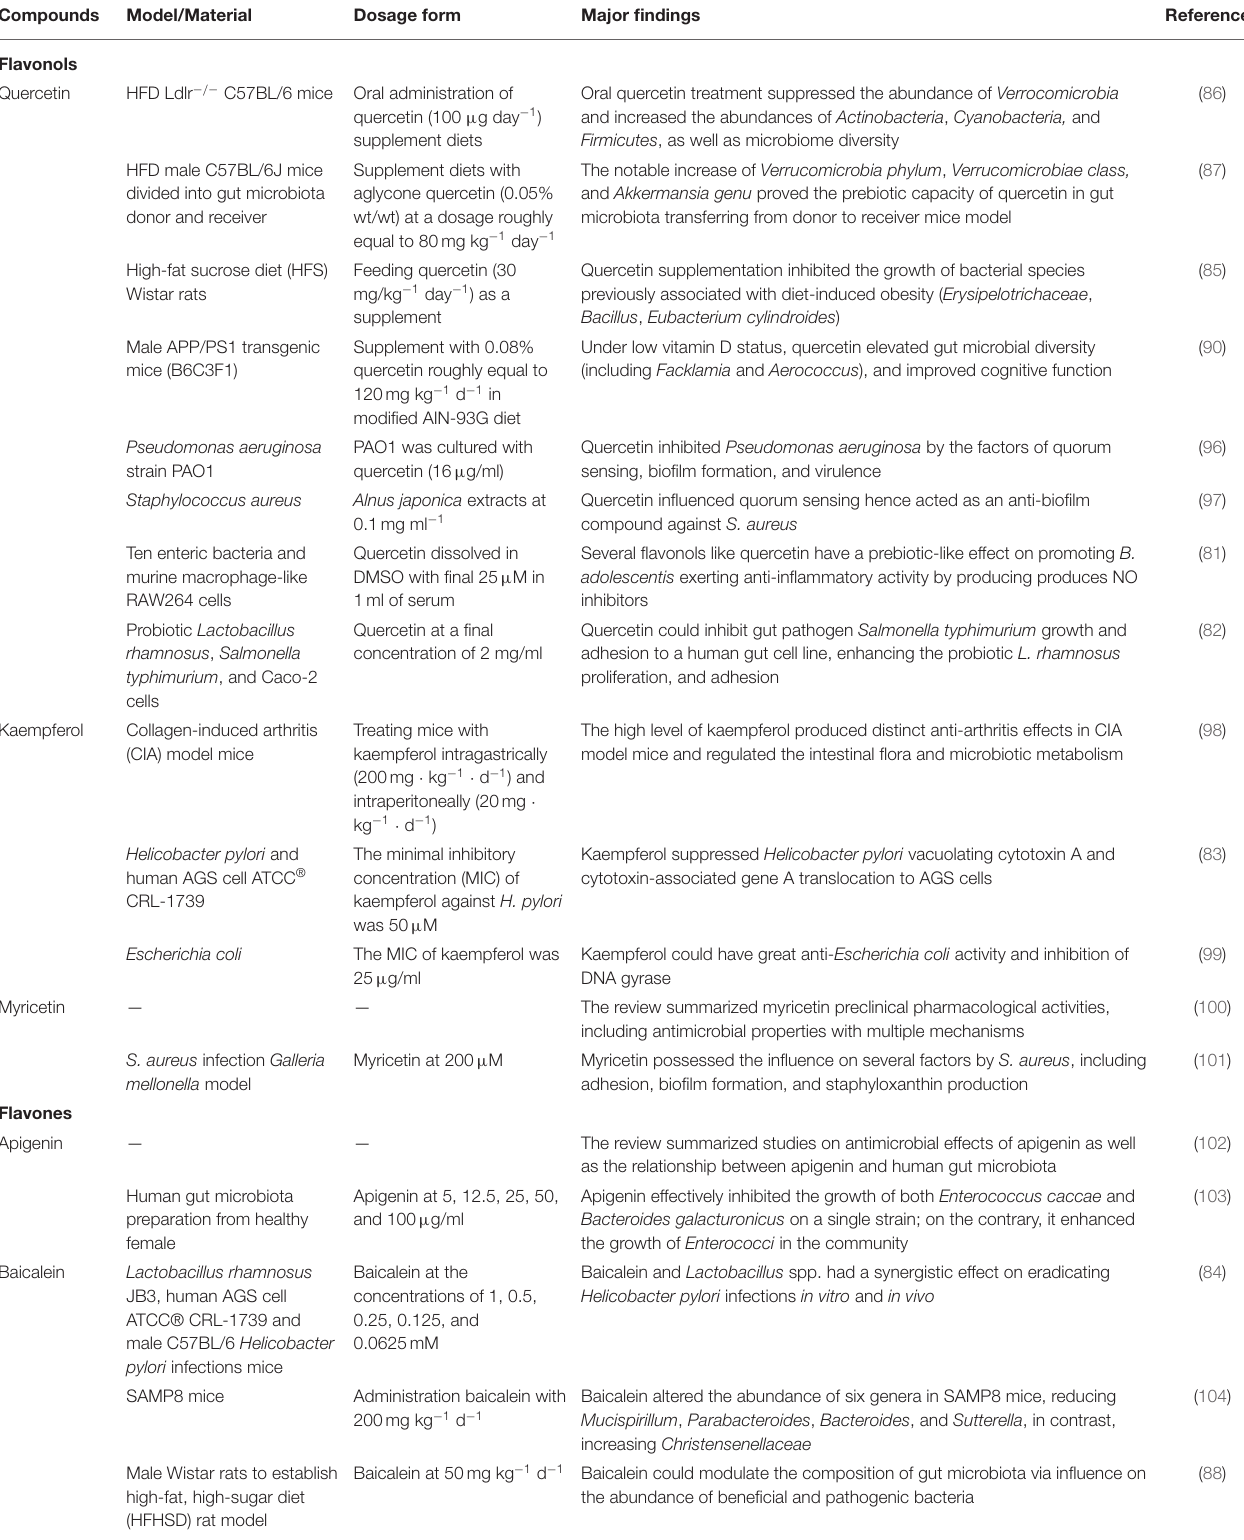
TABLE 1 | The regulatory effect of flavonoids on the gut microbiota.